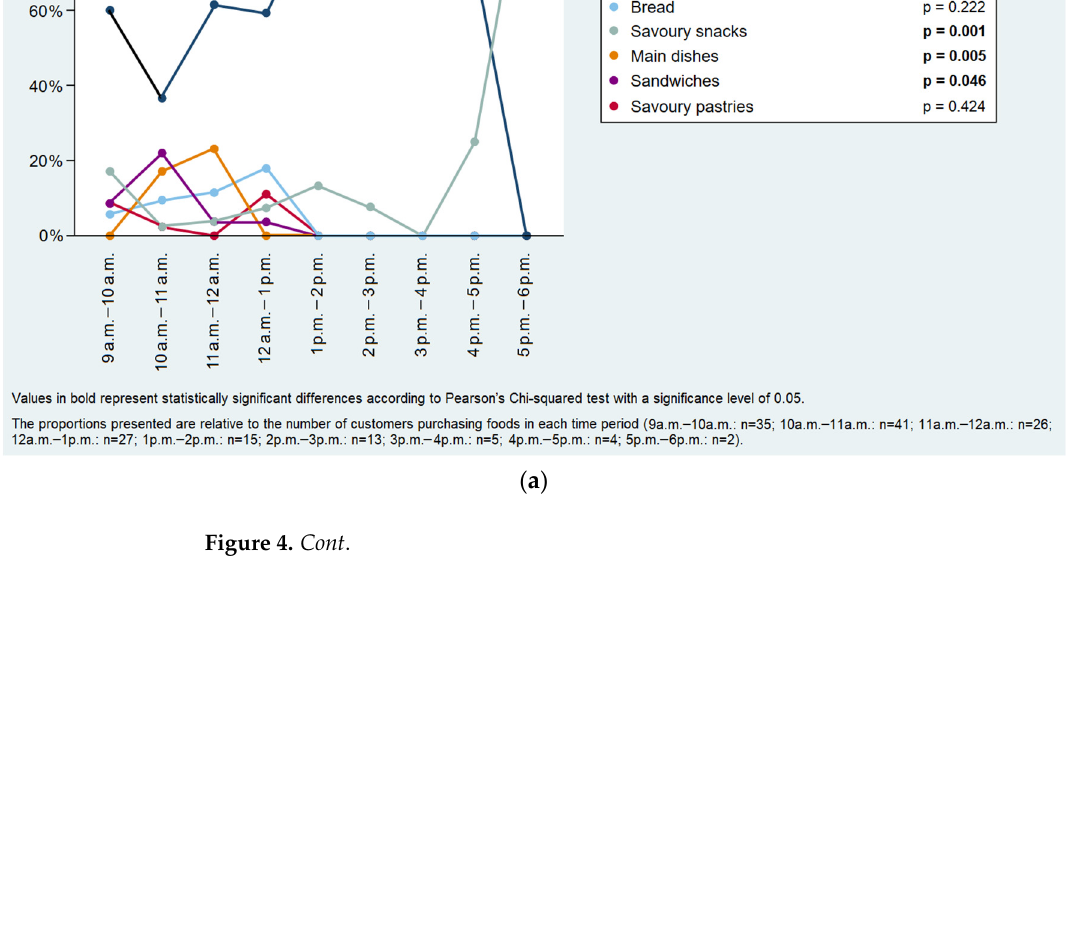
of customers buying yoghurt was significantly higher in the peripheries (Figure 6b).